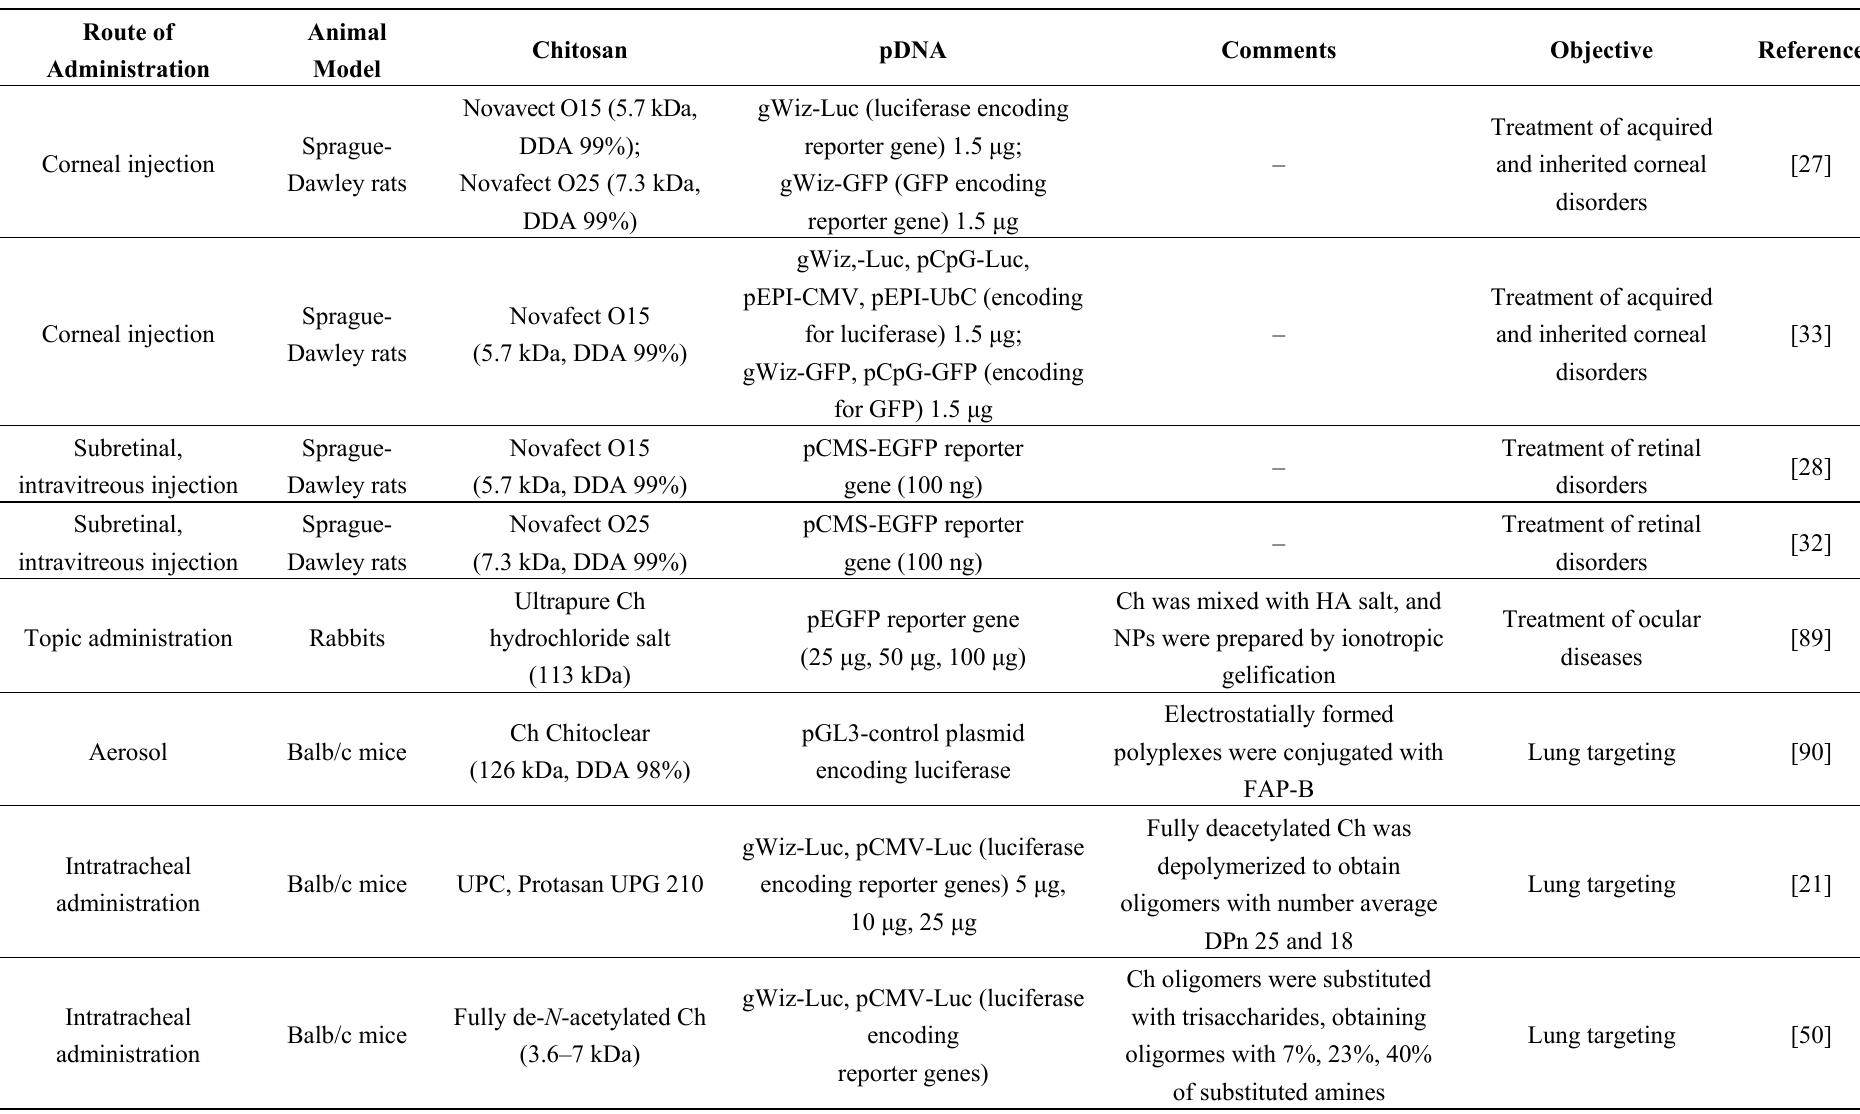
Table 2. Selected studies using LMWC based polyplexes for pDNA